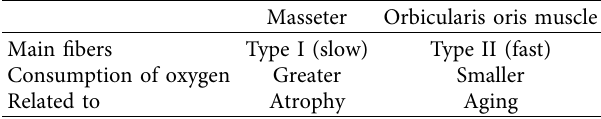
Table 2: Summary of previously published